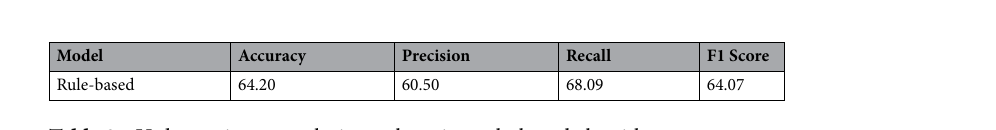
Table 8. Urdu sentiment analysis results using rule-based algorithm.